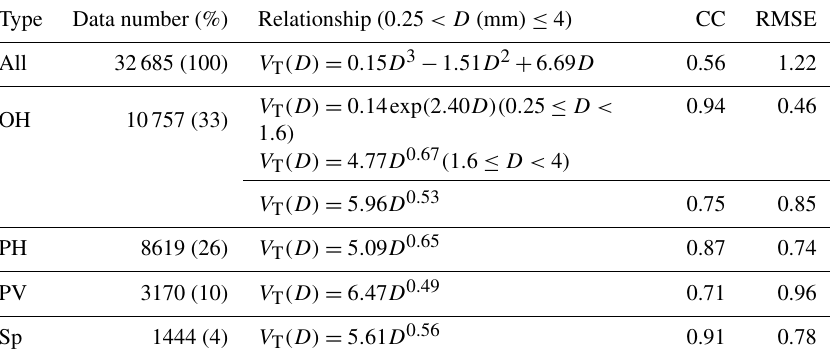
Table 3. Relationships of terminal velocity, with the number of data points, the value of the correlation coefficient (CC), and the root-mean- square error (RMSE), after applying the 60% V T QC threshold for each particle shape type.